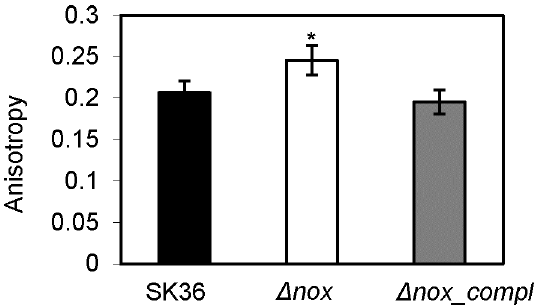
Fig 4. Change in membrane fluidity in the nox mutant. Δ nox , the nox mutant; Δ nox_compl , the complemented strain of the nox mutant. * , significant difference with P < 0.05 compared to SK36. Data obtained at least in